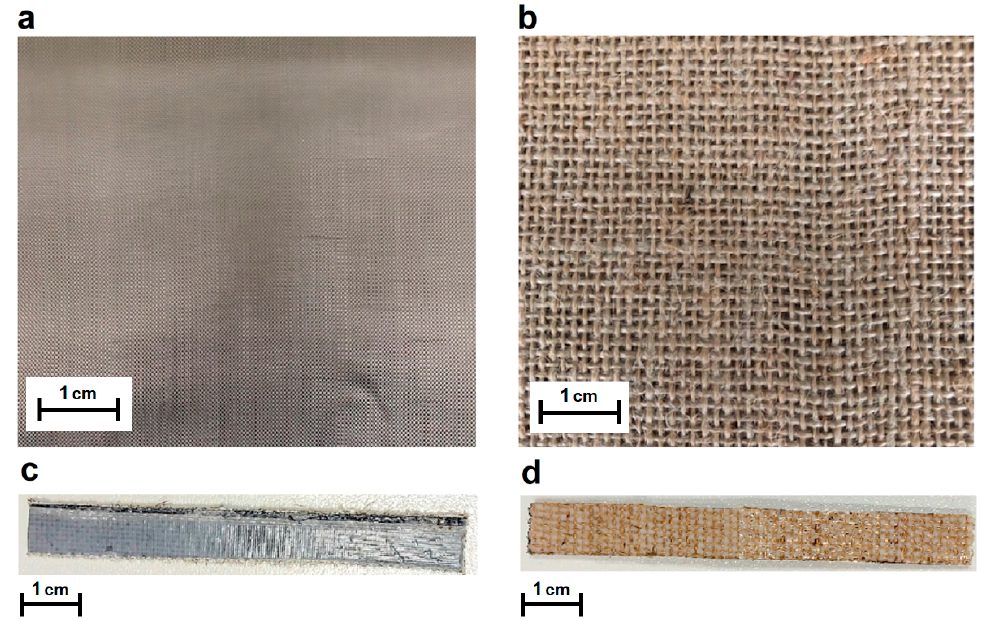
Figure 1. Pictures of the raw materials used: plain weave basalt fabric ( a ) and plain weave jute fabric ( b ). Pictures of the specimens fabricated: A500/Basalt ( c ) and A500/jute ( d ).